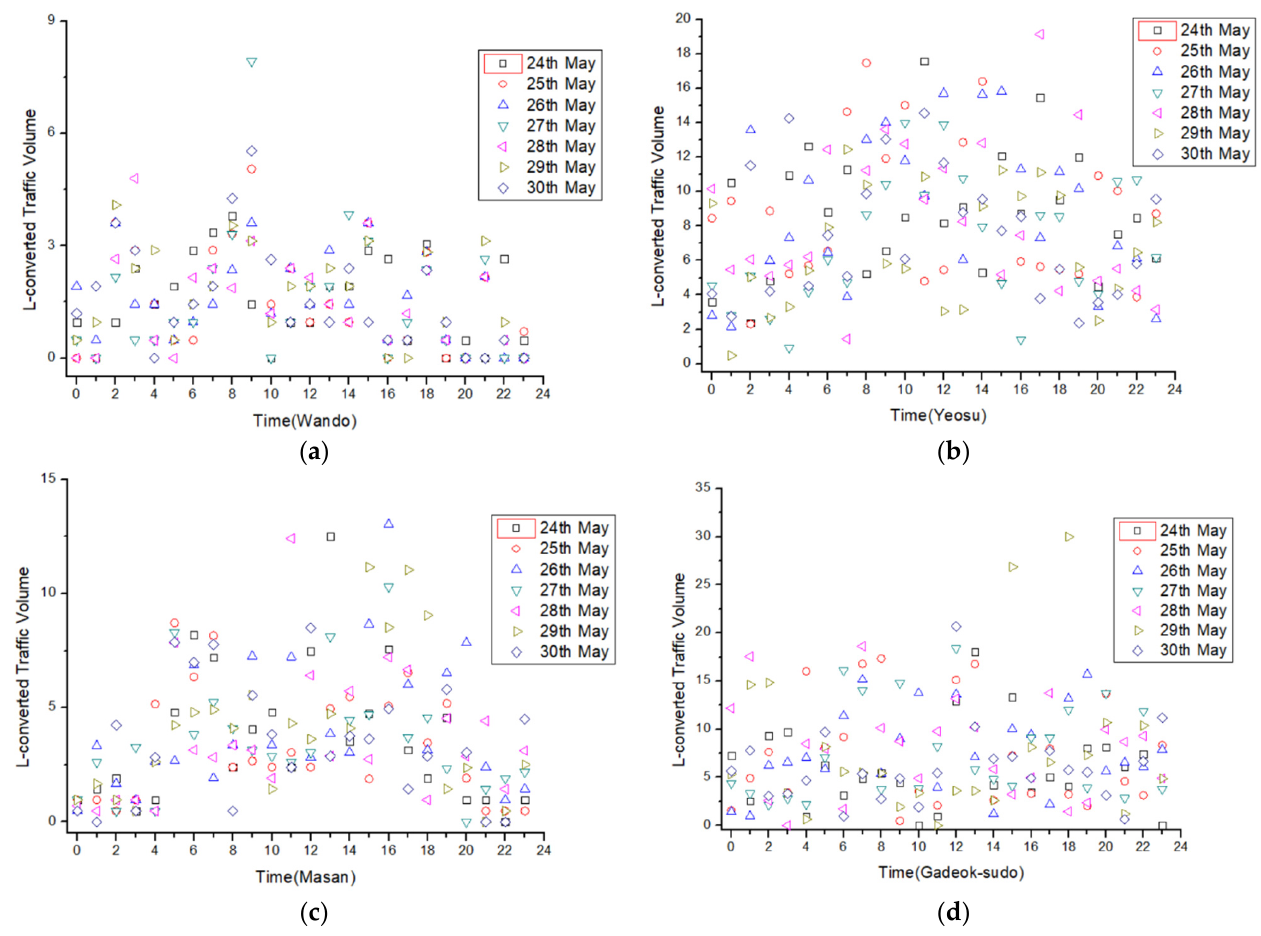
Figure 5. ( a ) L-converted traffic volume by time in the Wando fairway, ( b ) Yeosu area in Specific Traffic Safety Waters, ( c ) the Masan fairway, and ( d ) the Gadeok fairway.